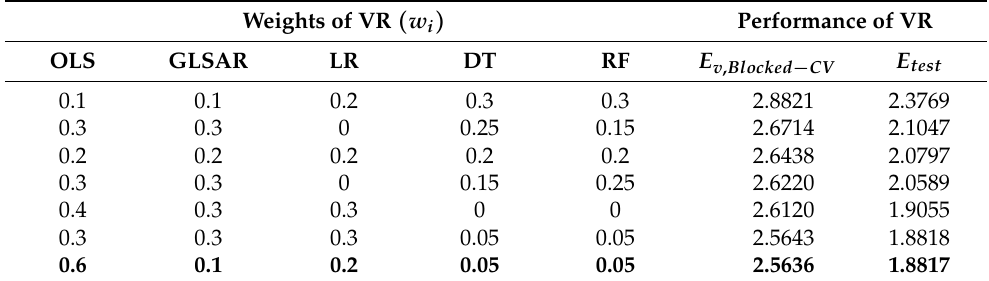
Table A5. Performance of VR based on different weights for the individual models (Group